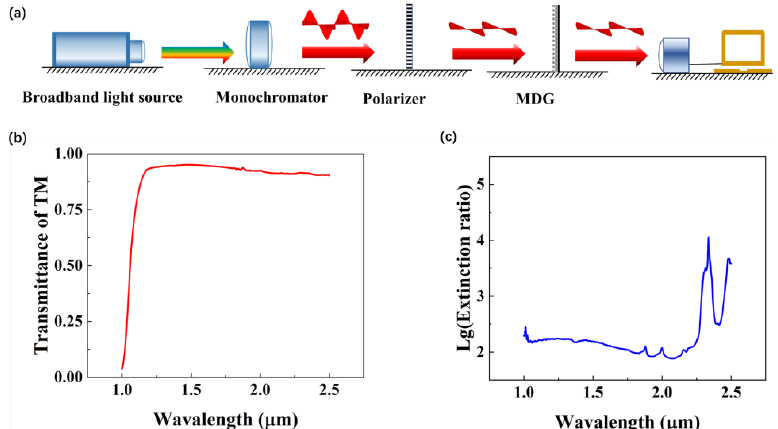
Figure 4. Schematic and MDG experimental results. ( a ) Schematic diagram of the test. ( b ) TM transmittance. ( c ) Extinction ratio (logarithmic scale).